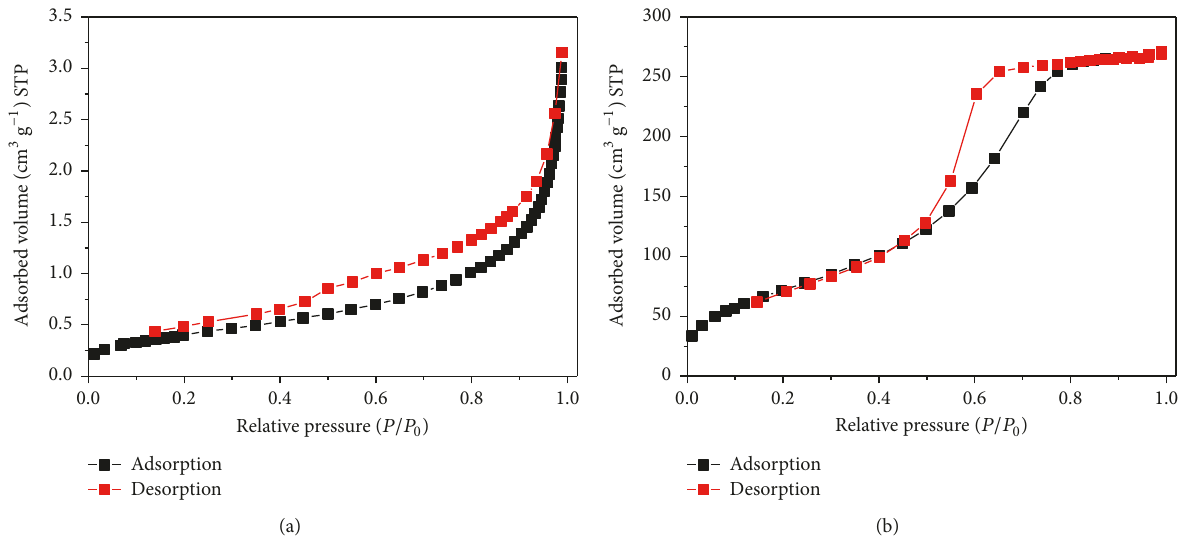
Figure 9: Nitrogen adsorption-desorption isotherms for the samples: ash (a) and biosilica